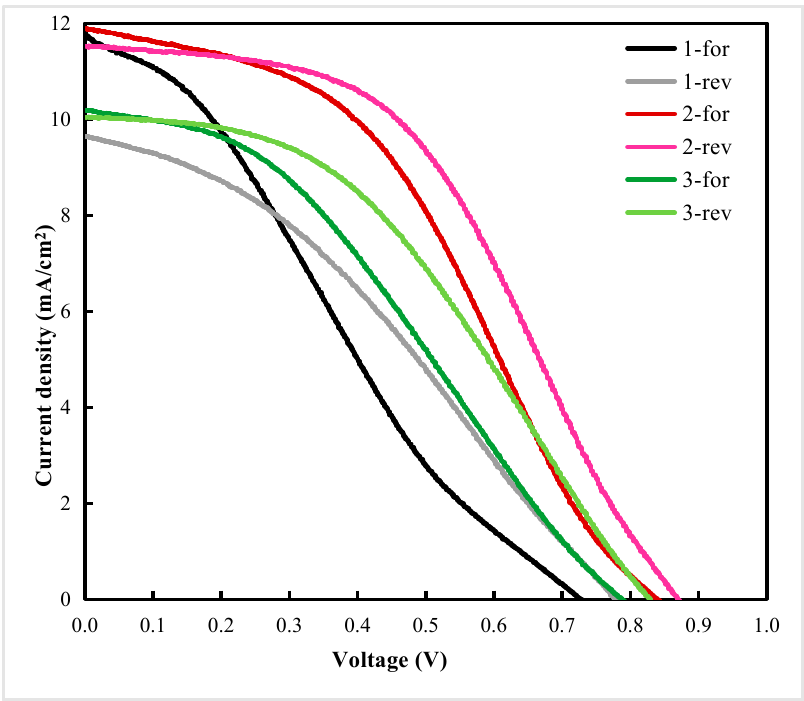
Figure 7. Current–voltage (J–V) curves of perovskite solar cells with different spin-coating cycles.